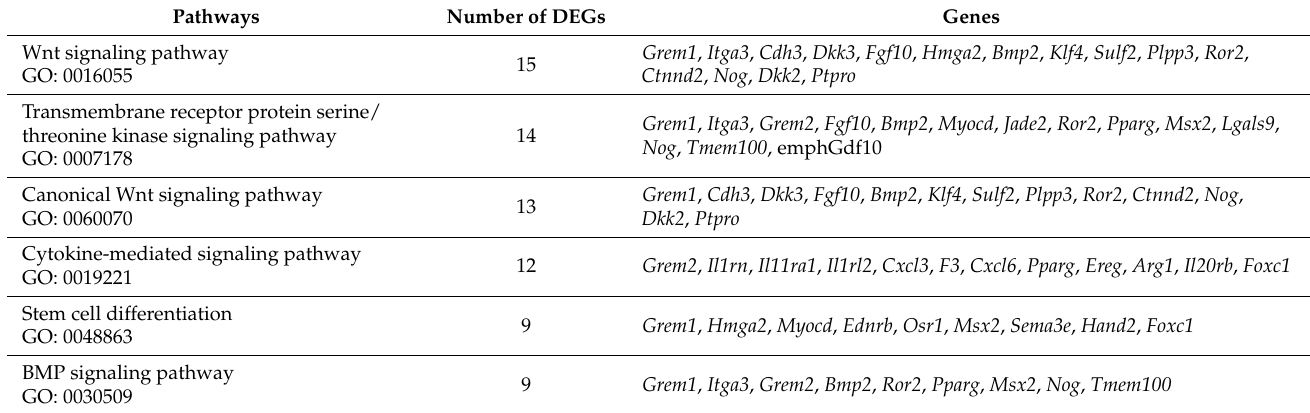
Table 3. Pathways associated with the DEGs downregulated in HS7 vs CONTR ( p <